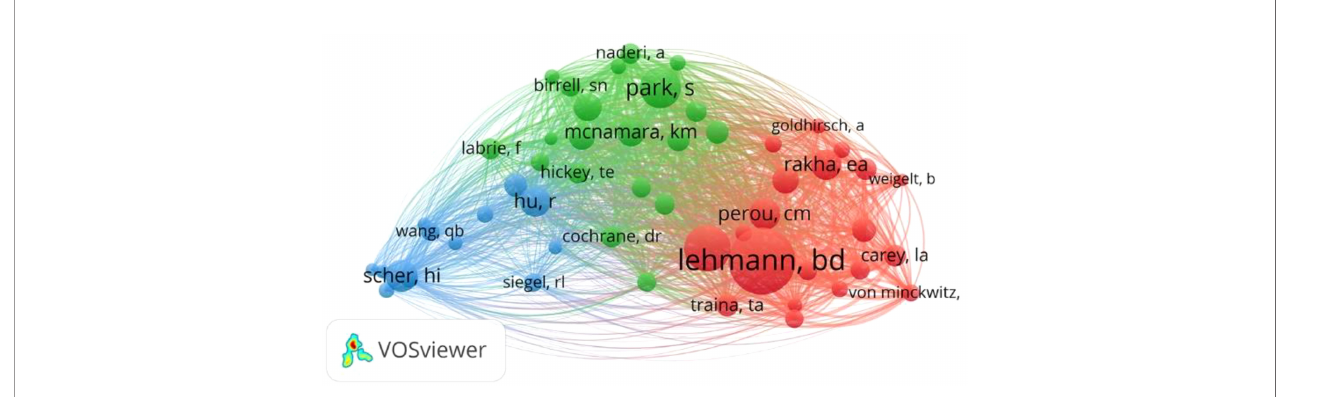
FIGURE 6 | Network map of co-citations between authors with the minimum citations over